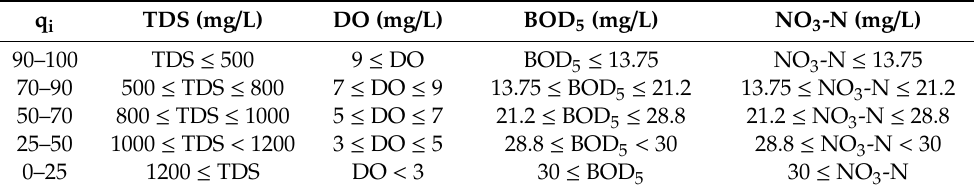
Table 3. Parameter limiting values utilized in the IWQI.